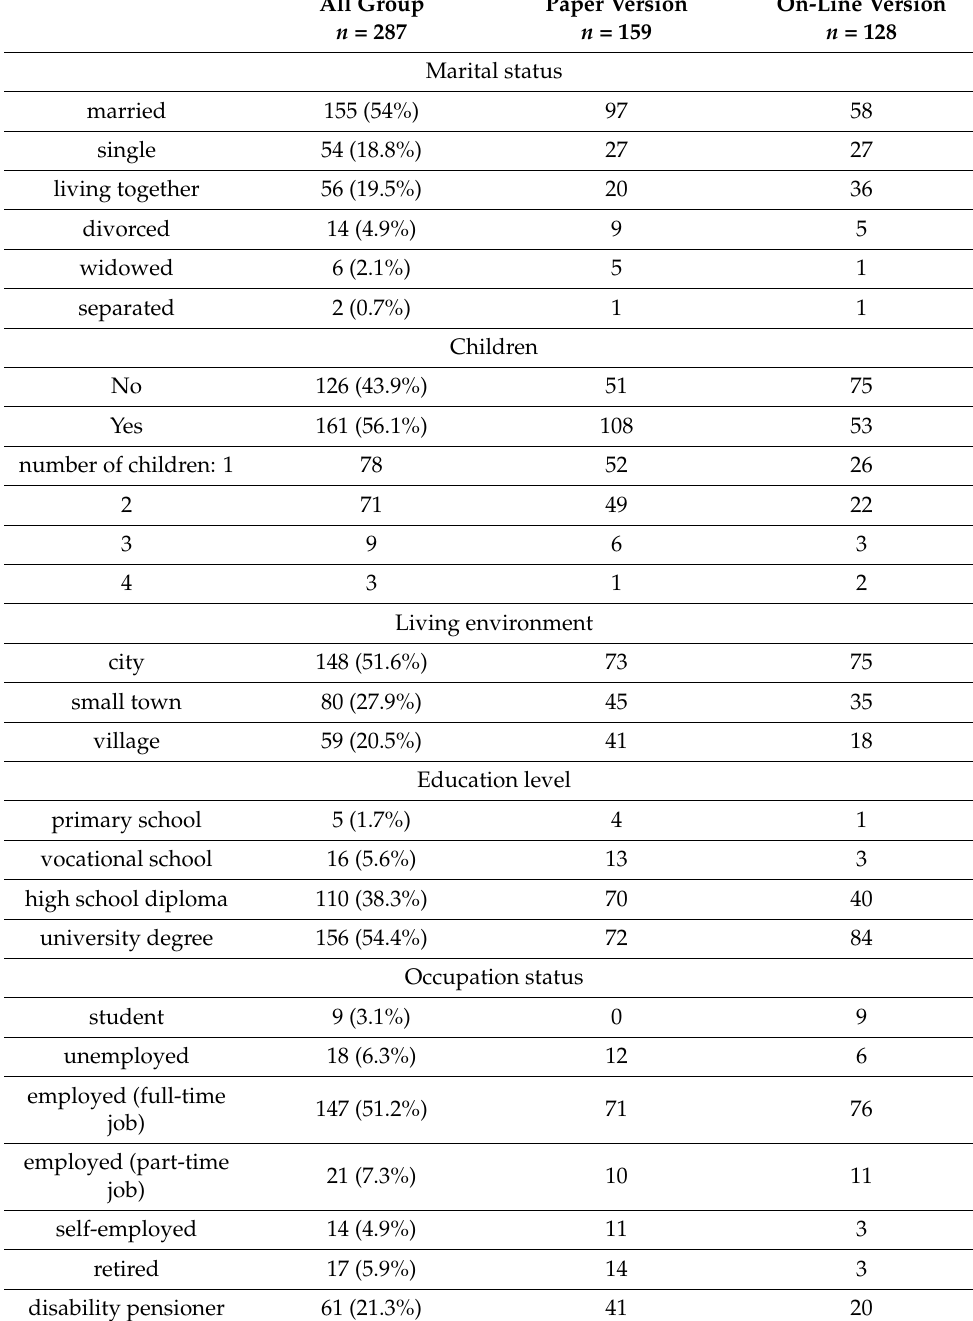
Table 1. Demographic characteristics of the study